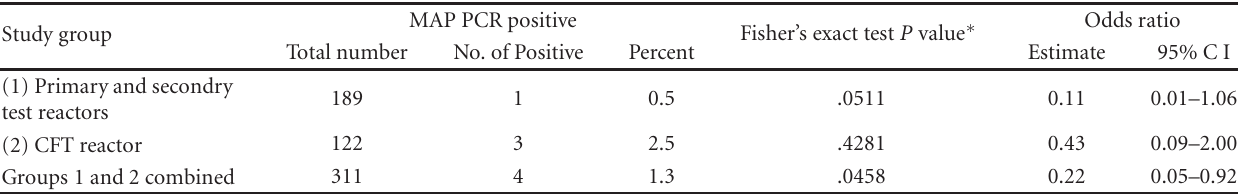
Table 3: Odds ratios for M. bovis test reactors compared to M. bovis test negative cattle, by PCR-confirmed MAP status. Study